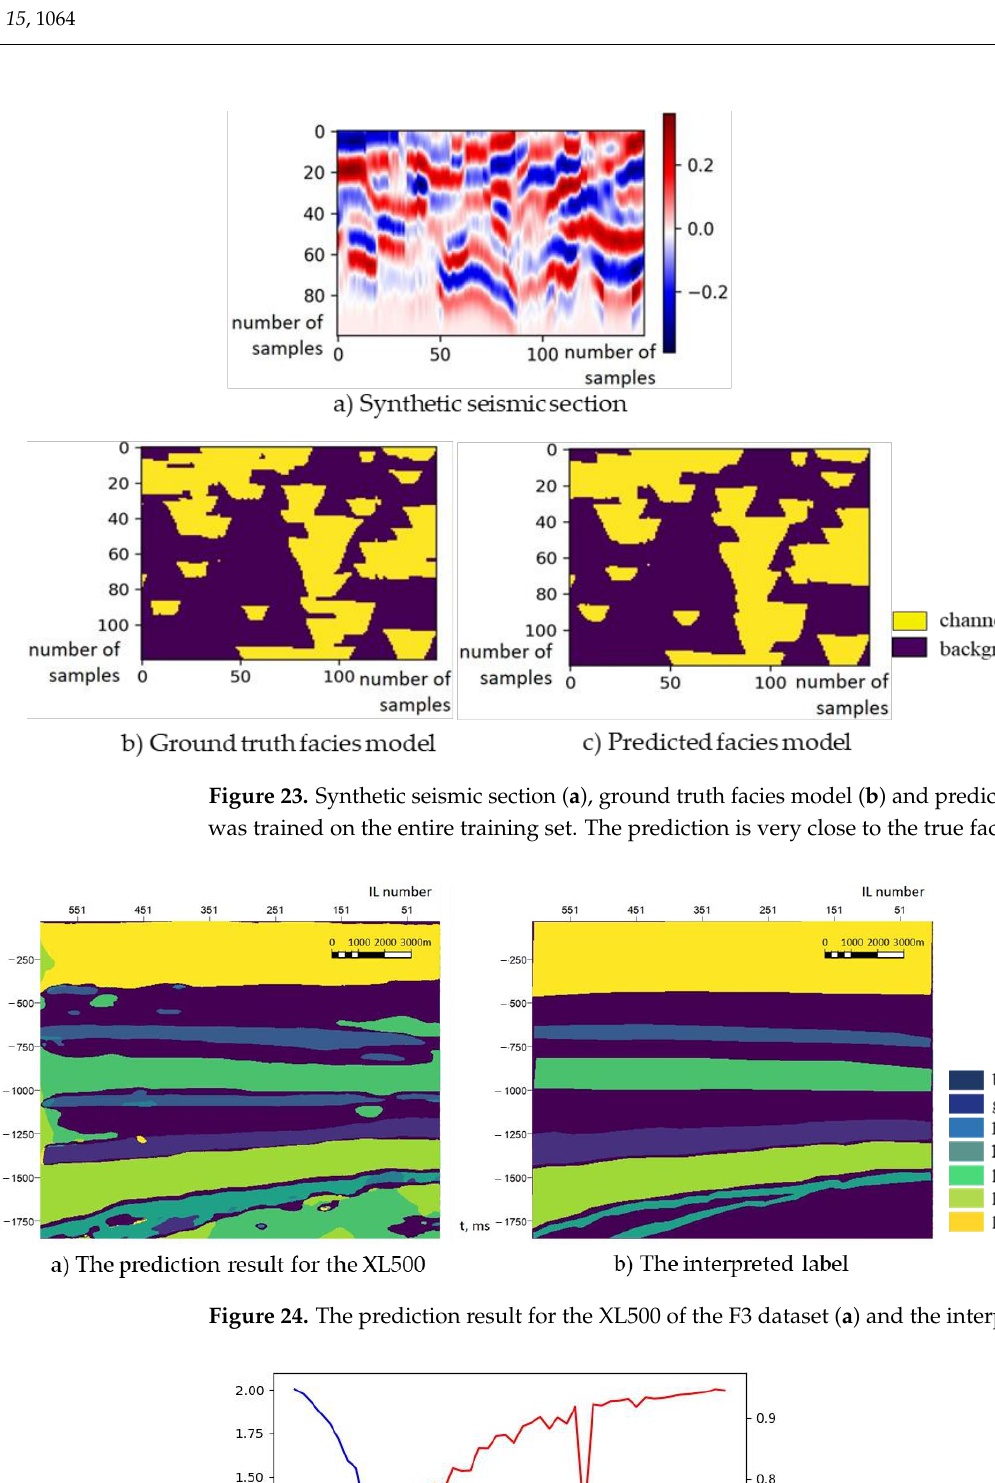
Figure 22. Synthetic seismic section ( a ), ground truth facies model ( b ) and predicted result ( c ). U- Net was trained on 13 training examples. In the prediction the true facies distribution is captured.